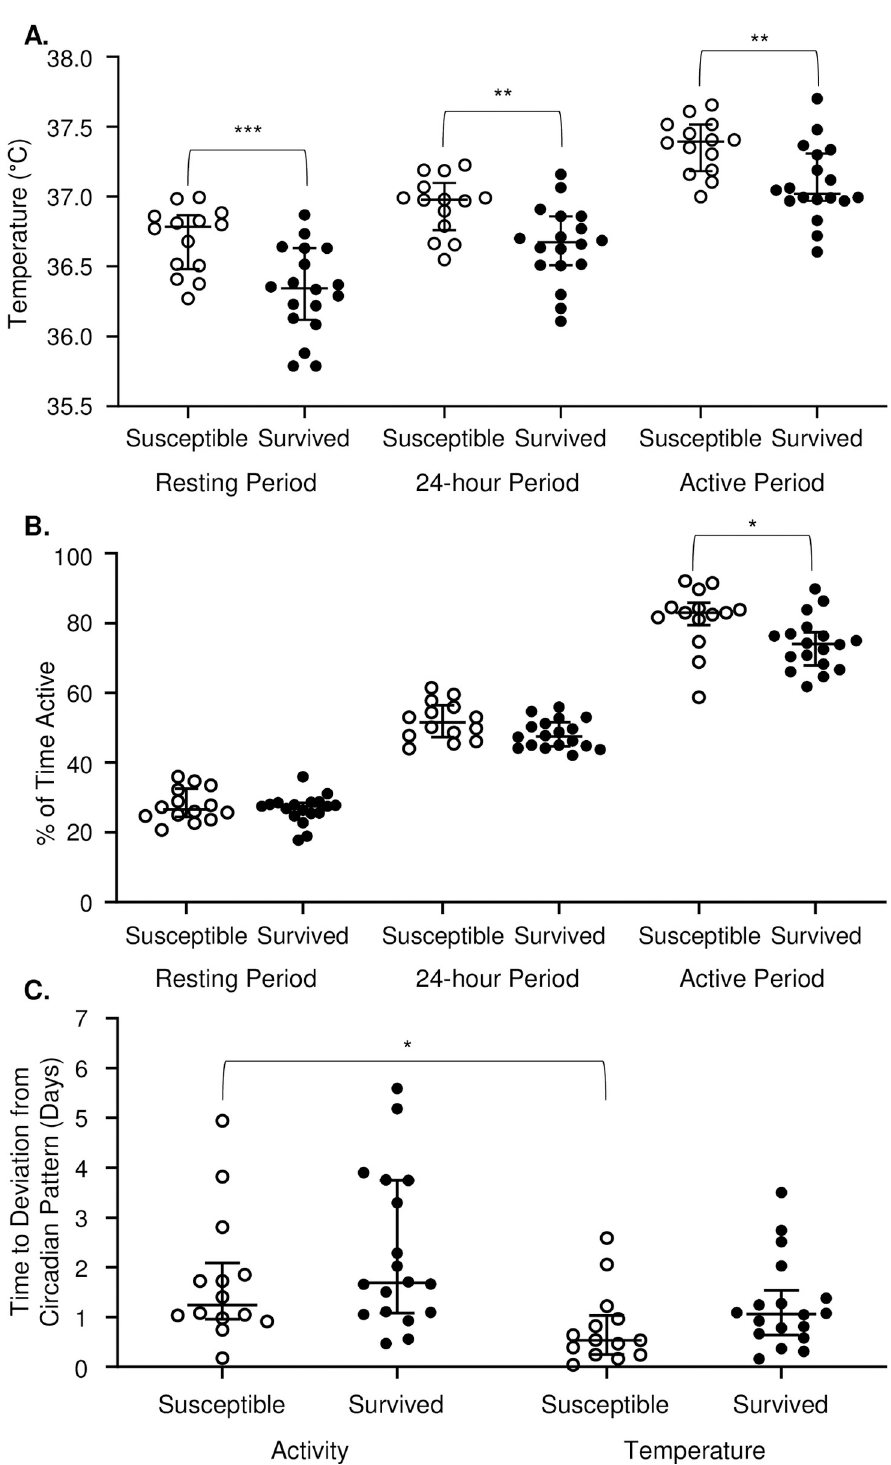
Fig 4. At pre-infection baseline, susceptible strains have higher body temperatures, are more active during normal rest period, and maintain activity patterns longer than temperature patterns than surviving strains. Resting period, 24-hour period, and active period strain medians shown for A. temperature and B. percent of time active. C. Time to deviation from baseline activity and temperature post-infection (days). Strains are grouped by survival status. Median overall values and interquartile range are indicated. A two-tailed Mann-Whitney test was used to determine statistical significance ( � P < 0.05, �� P < 0.01, ��� P < 0.001).